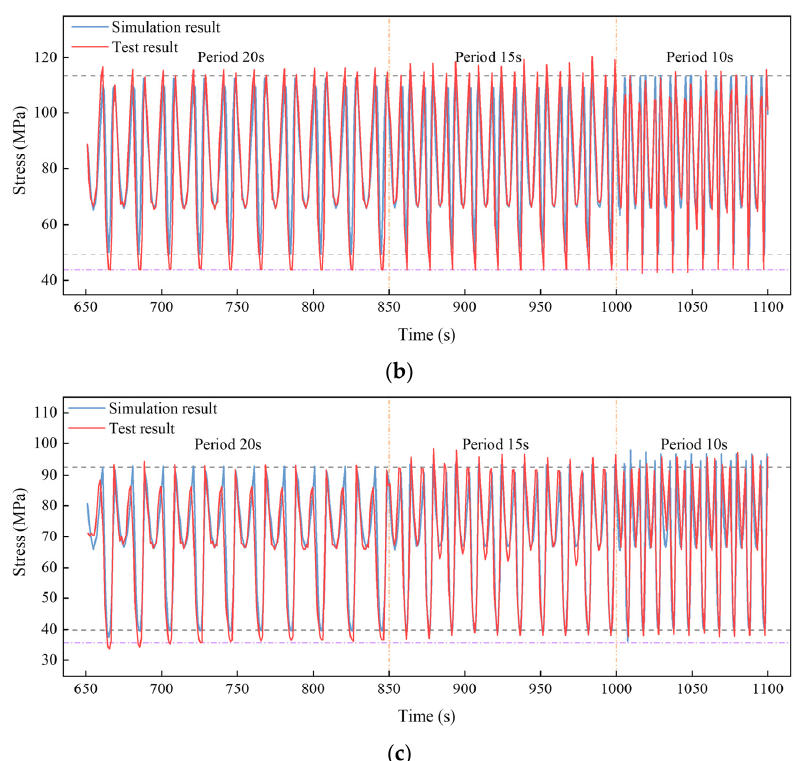
Figure 28. Time histories of the in-plane stress when the amplitude was 300 mm and the period decreased from 20 s to 10 s: ( a ) S2; ( b ) S5 and ( c ) S8.